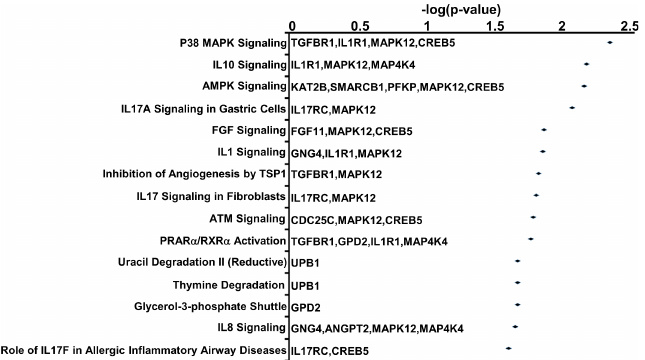
Fig 6. Canonical pathway analysis of genes with the DMPs of PBMCs isolated from ME/CFS cases. Genes listed to the right belong to the respective pathways. Gene Ontology analysis was performed using the Ingenuity Pathway Analysis (IPA) on 307 genes with the